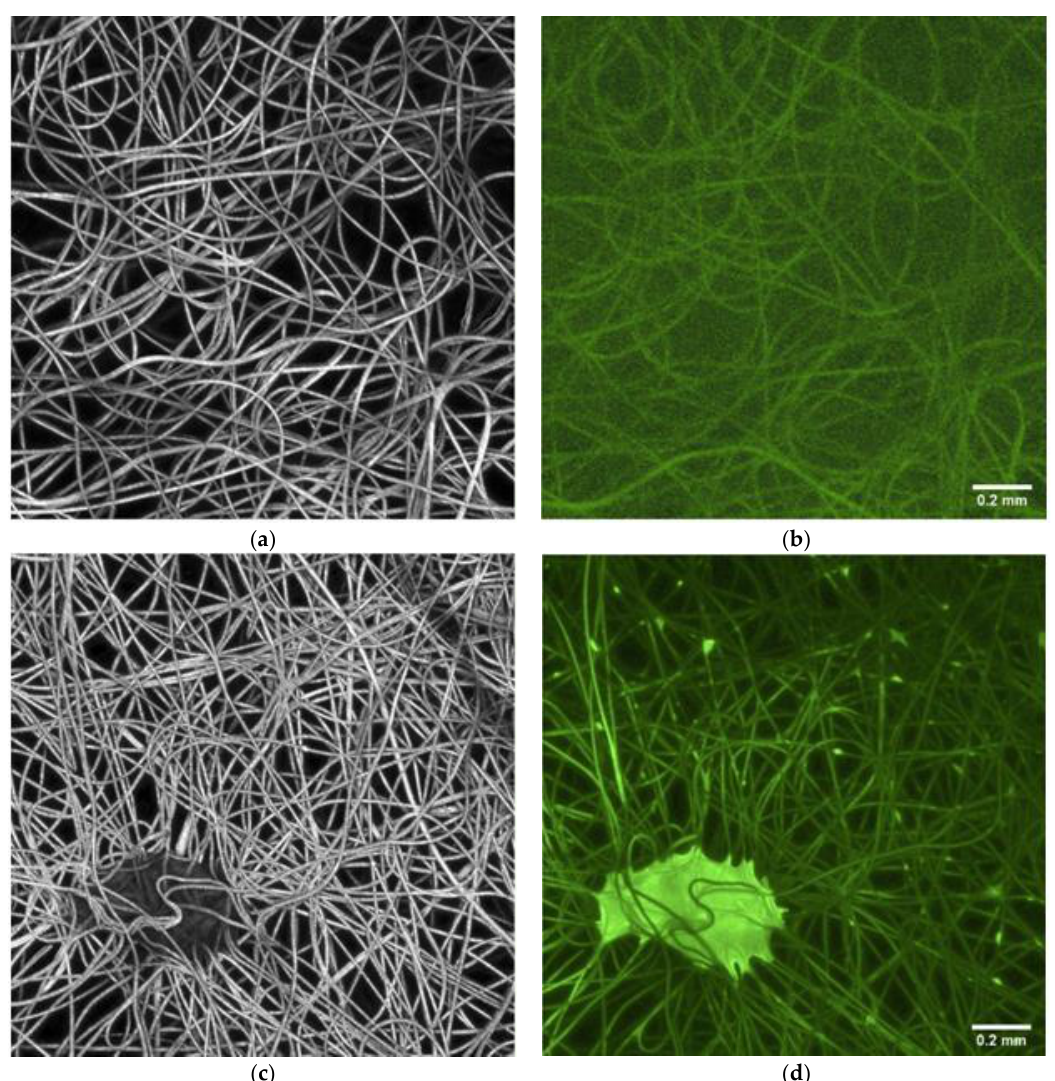
Figure 2. Cross-section CLSM pictures in normal ( a) , ( c ) and fluorescence ( b) ,( d ) mode of pure PS material ( a) ,( b ) and PS material with alginate immobilized bacteria ( c) , ( d ).